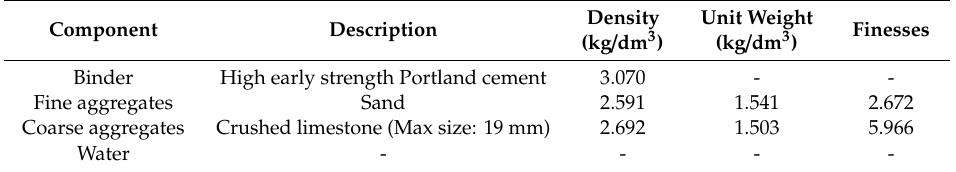
Figure 1. A flowchart describing the experimental procedure used to characterize Portland cement and its aggregates. Table 3. Parameters of the raw materials used for concrete preparation in this study.